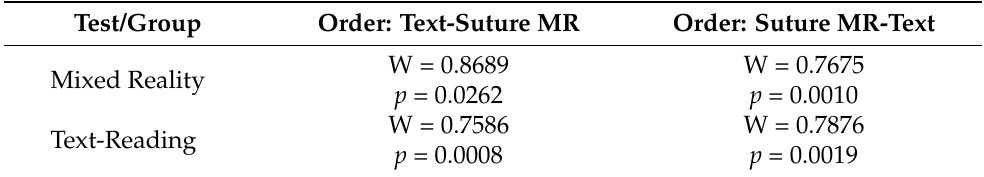
Table 1. Results (statistic W and p -value) of retentive score on different Learning Sessions order obtained throughout the Shapiro–Wilk Normality